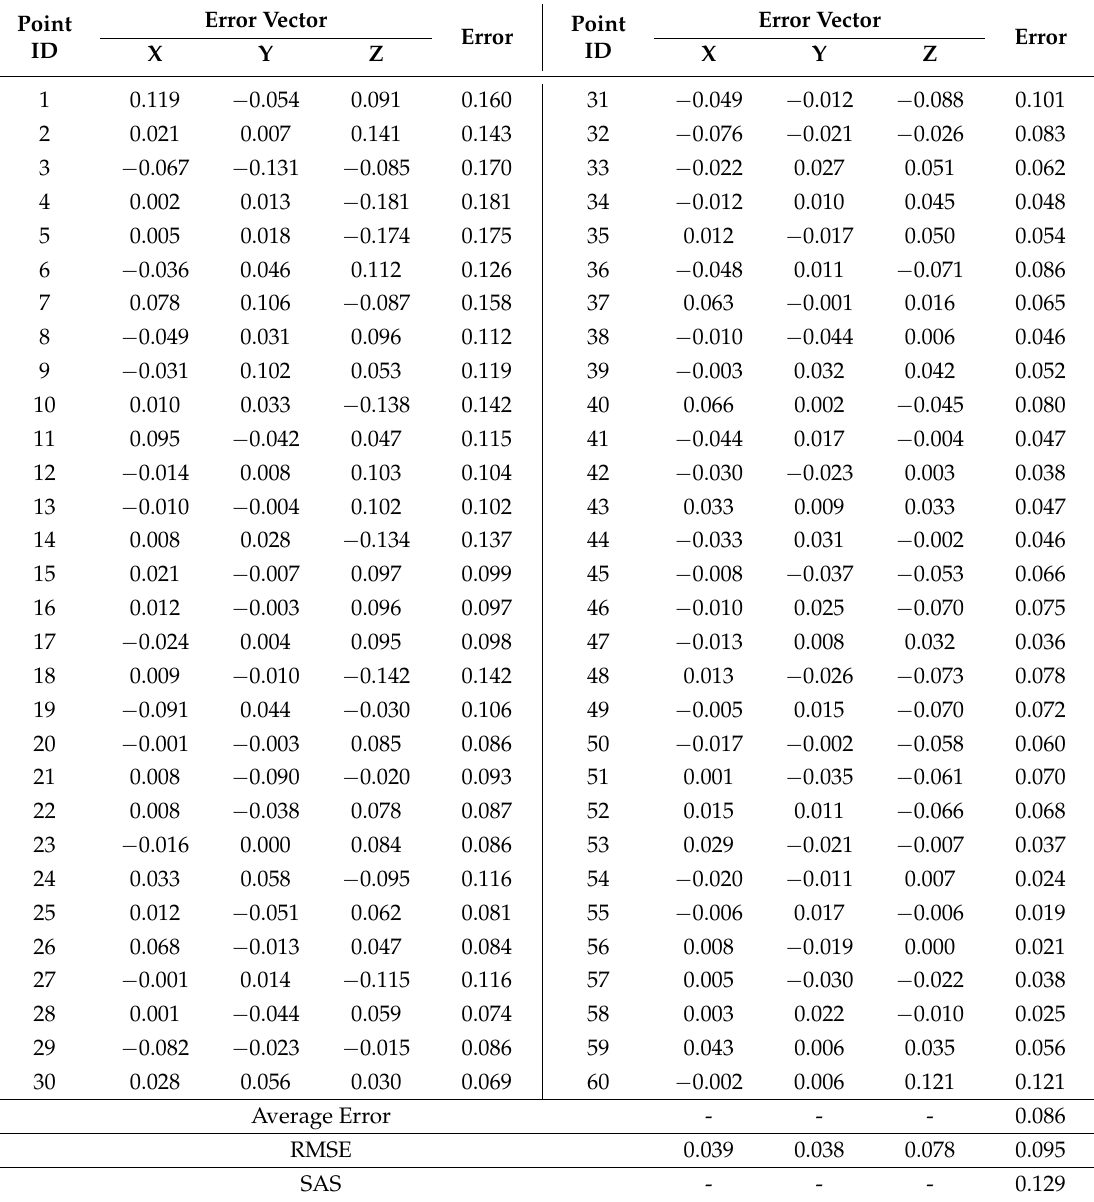
Table 3. Accuracy assessment results (unit: